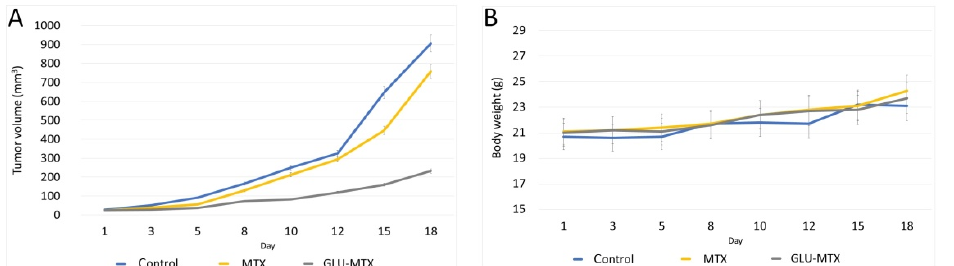
Figure 6. Results of the in vivo study. ( A ) The average tumor volume after 18 days in 3 groups (1—control, 2—MTX-treated and 3—GLU–MTX treated). In group 3, the tumor volume was significantly lower compared to other groups, as analyzed by one-way ANOVA followed by Bartlett’s test ( p < 0.001). ( B ) The effect of the therapy on body weight. No significant loss of body weight has been observed.